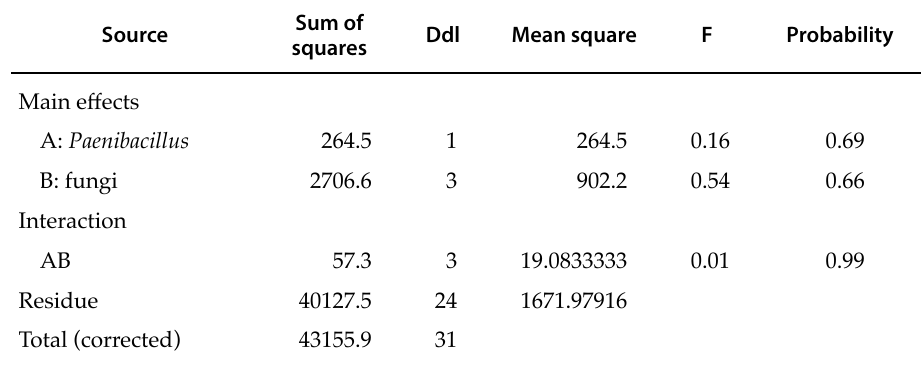
Table 4. ANOVA for “Root fresh weight” in mg - type III Sum of